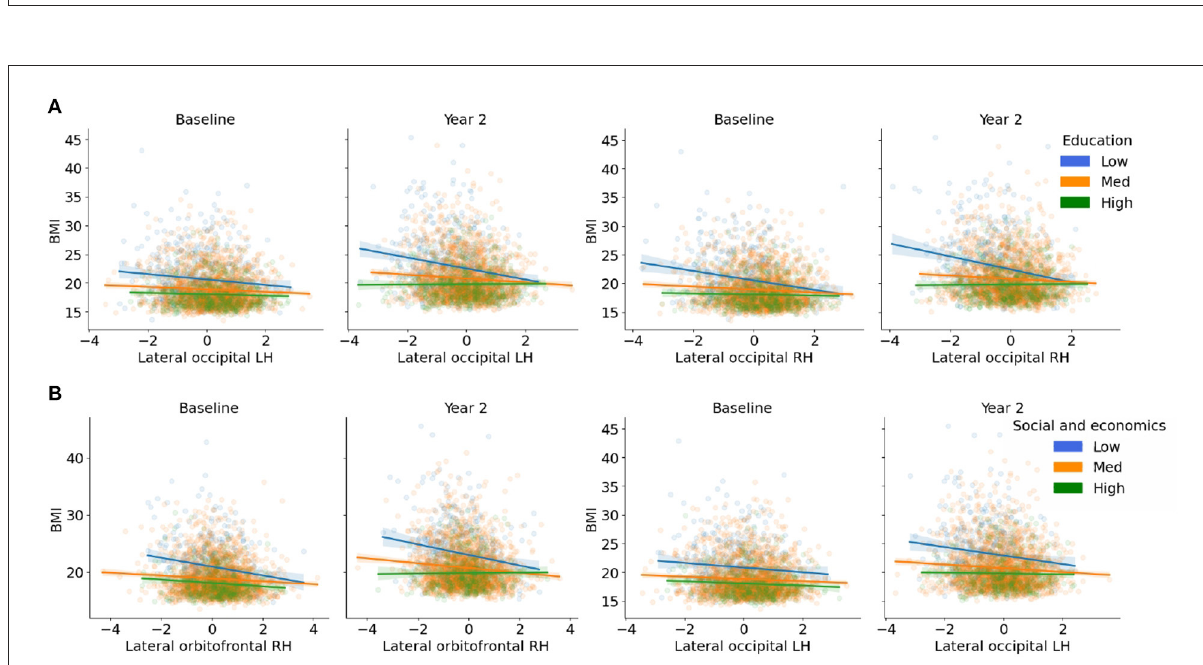
FIGURE3 (A,B) Visualization of the three-way interactions between the brain, each Child Opportunity Index (COI) domain of interest, and time (e.g., visit number [baseline, year-two follow-up]), controlling for the other two COI domains of no interest, income-to-needs, sex, puberty, race, and ethnicity. The top two Brain * COI * Time interactions are plotted for each domain. The y-axis presents the body mass index (BMI) predicted fits from the regression. (A) COI ED ; (B) COI SE . Low (blue), medium (orange), and high (green) correspond to the values of each COI at − 1 standard deviation (SD) below the mean, at the mean, and 1 SD above the mean. Fit lines indicate the regression fit with a 95% confidence interval. Individual points (i.e., subjects) are represented by the dots for each color. Lower values of each COI indicate that there were fewer resources in the area. RH, right hemisphere; LH, left hemisphere.